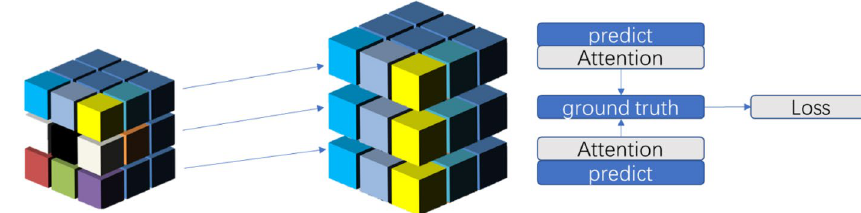
Figure 1. The architecture of MagicCubeNet.